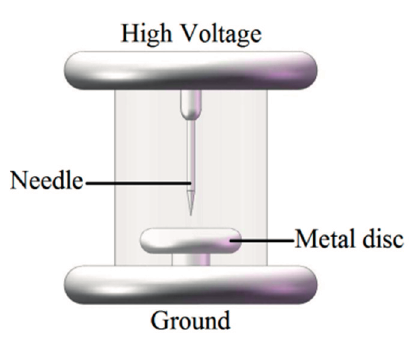
Figure 14. The PD experiment platform.